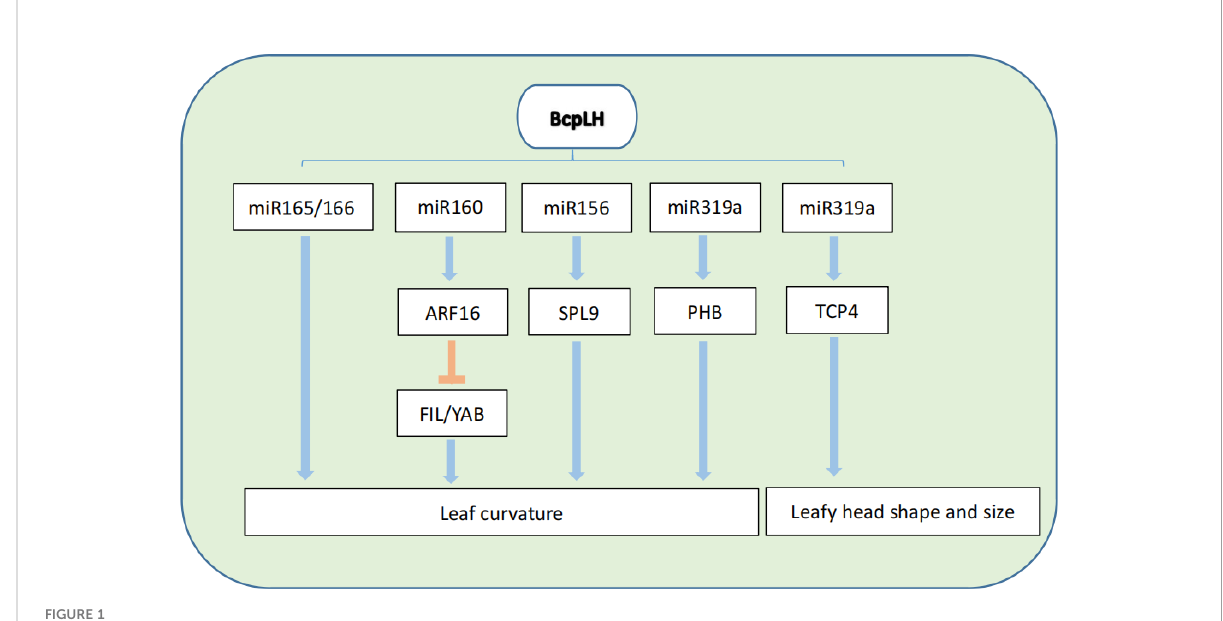
FIGURE 1 Genetic regulation of leafy head development in Chinese